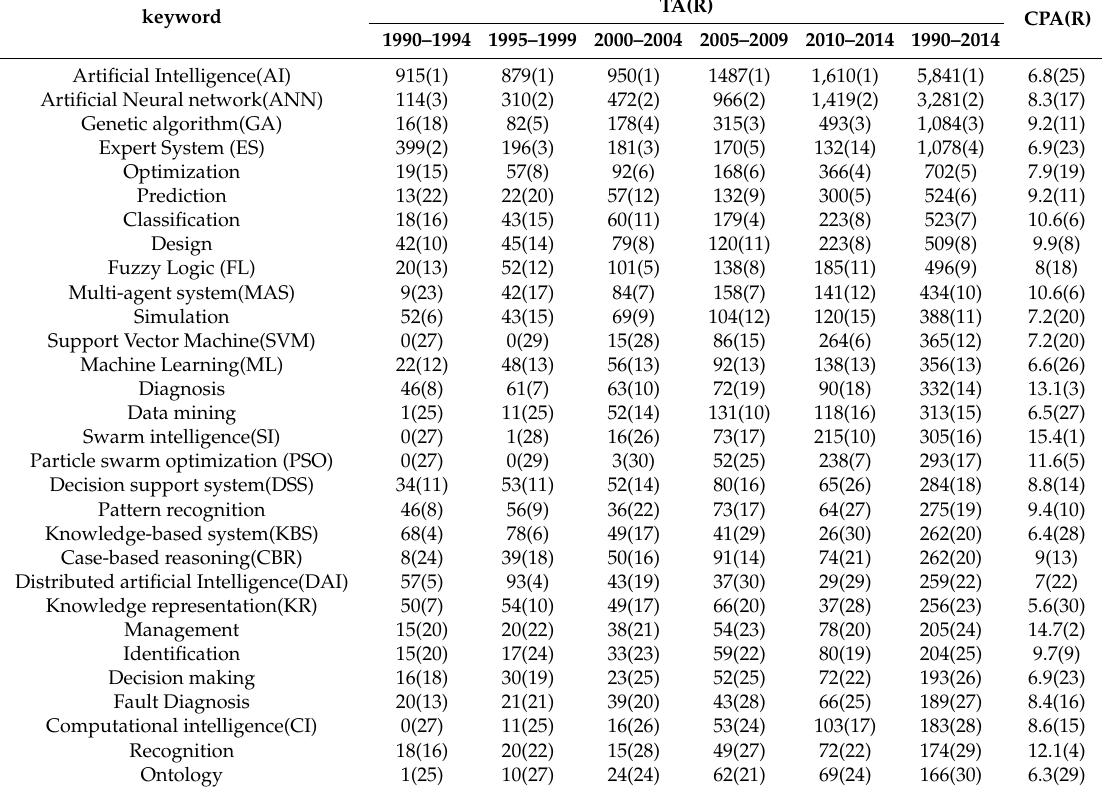
Table 6. Temporal pattern of frequently used